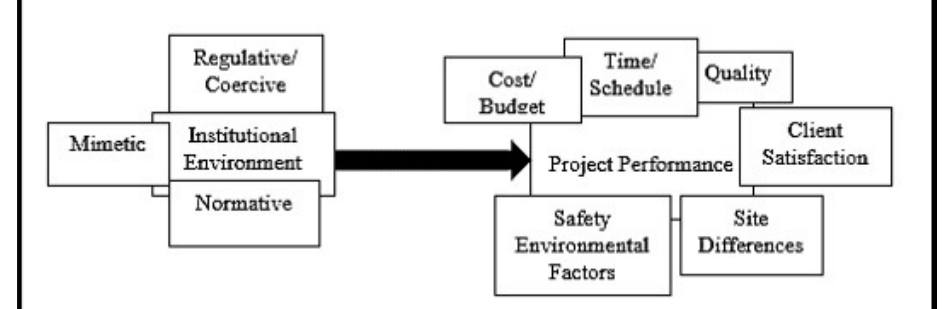
Figure 1: Conceptual